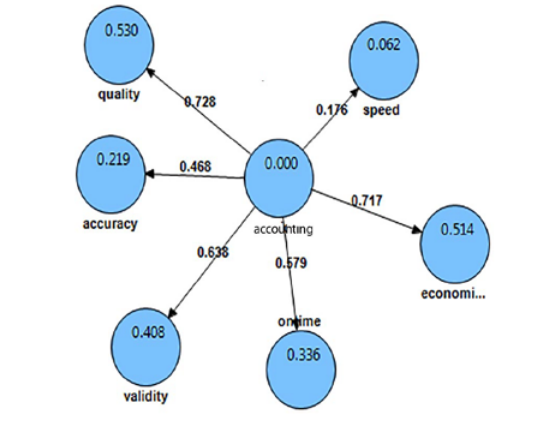
Fig. 4. Research structural model in standard mode Fig. 5. The results of t statistics amounts on path lines after Bootstrap Hypothesis